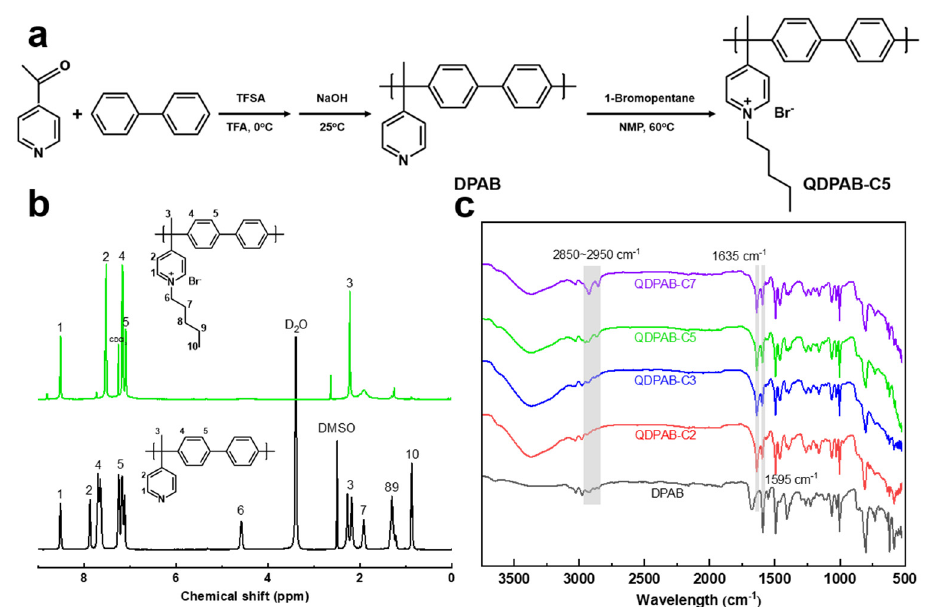
Figure 1. ( a ) The synthesis route of DPAB and QDPAB-C5 polymers; ( b ) 1 H NMR spectra of DPAB and QDPAB-C5 polymers; ( c ) ATR-FTIR spectra of DPAB and QDPAB-Cx membranes. and QDPAB-C5 polymers; ( c ) ATR-FTIR spectra of DPAB and QDPAB-Cx